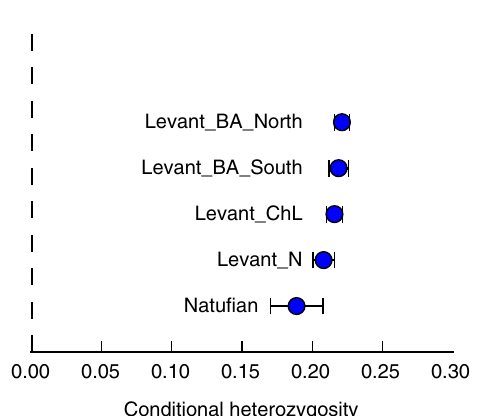
Fig. 2 Genetic diversity in the ancient Levant. Heterozygosity increases in ancient Levantine populations over time. The estimated statistic ± 3 standard errors is